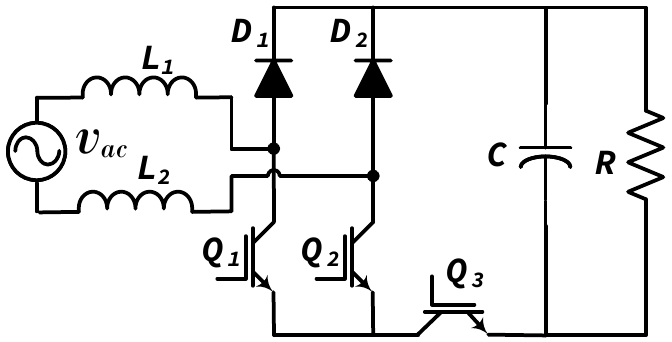
Figure 9. Semi-bridgeless boost converter with isolation.